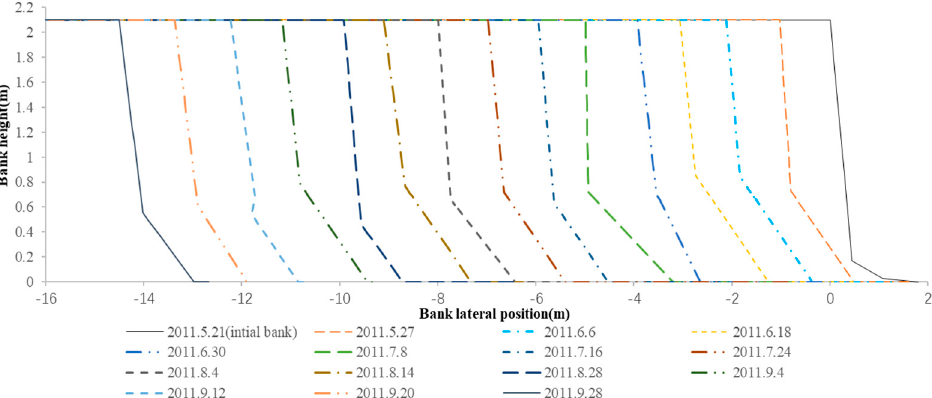
Figure 6. Collapse phases for surveying Section 1.